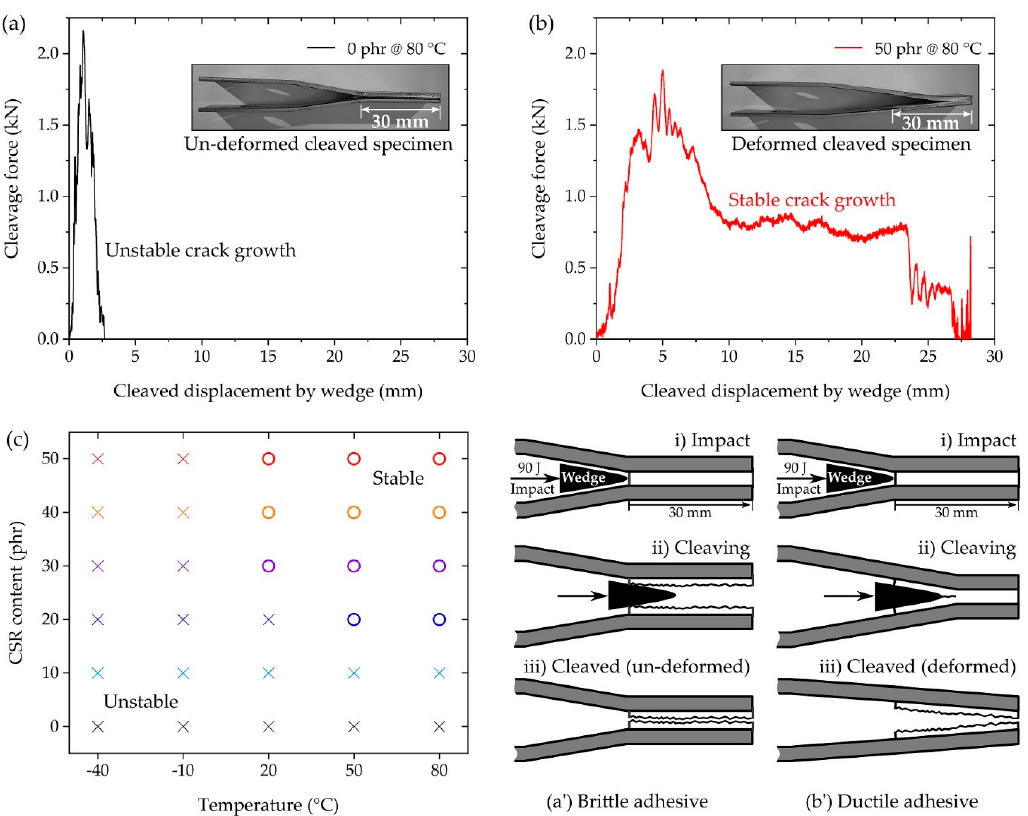
Figure 12. IWP test results depicting ( a ) unstable crack growth (0 phr @ 80 ◦ C), ( b ) stable crack growth (50 phr @ 80 ◦ C), and a ( c ) stable–unstable map of all compositions. Schematic illustration of the IWP specimen cleavage and deformation on a ( a’ ) brittle adhesive and a ( b’ ) ductile